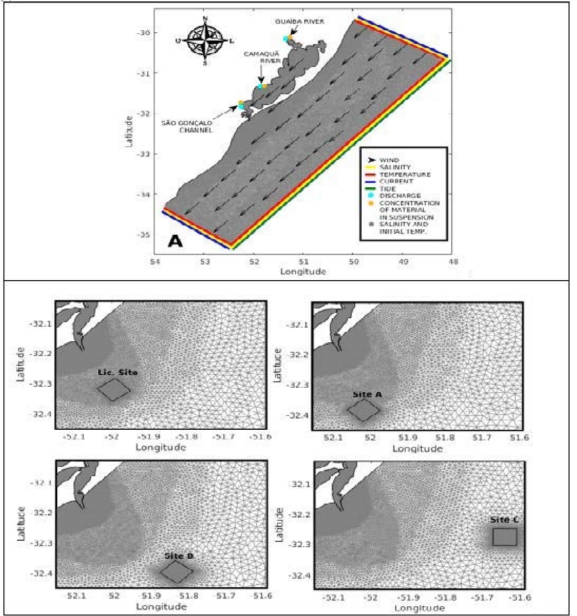
Figure 2. Top panel—The numerical grid for the computational domain identifying the initial and boundary conditions applied in the simulations. Bottom panel—Zoomed-in view of the meshes with the location of the licensed and alternative disposal Sites A, B, and C in the Port of Rio